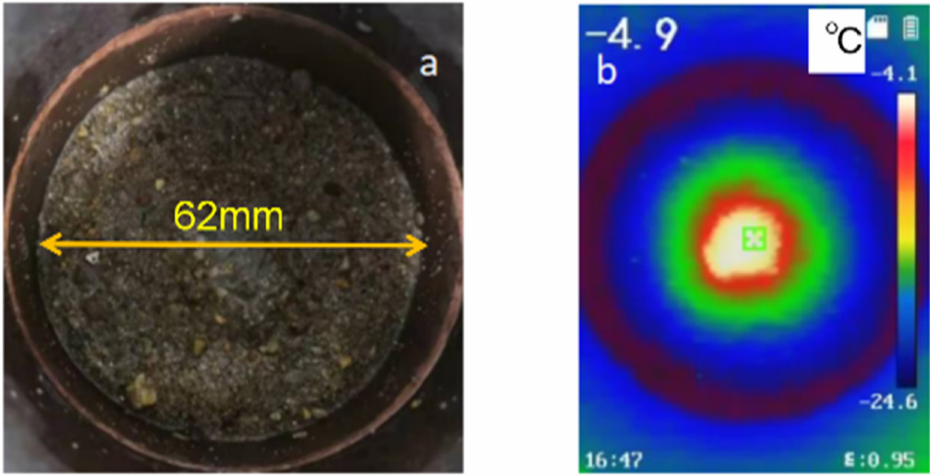
Figure 5. ( a ) Photograph of the sand–ice valve. ( b ) Thermal image of the sand–ice